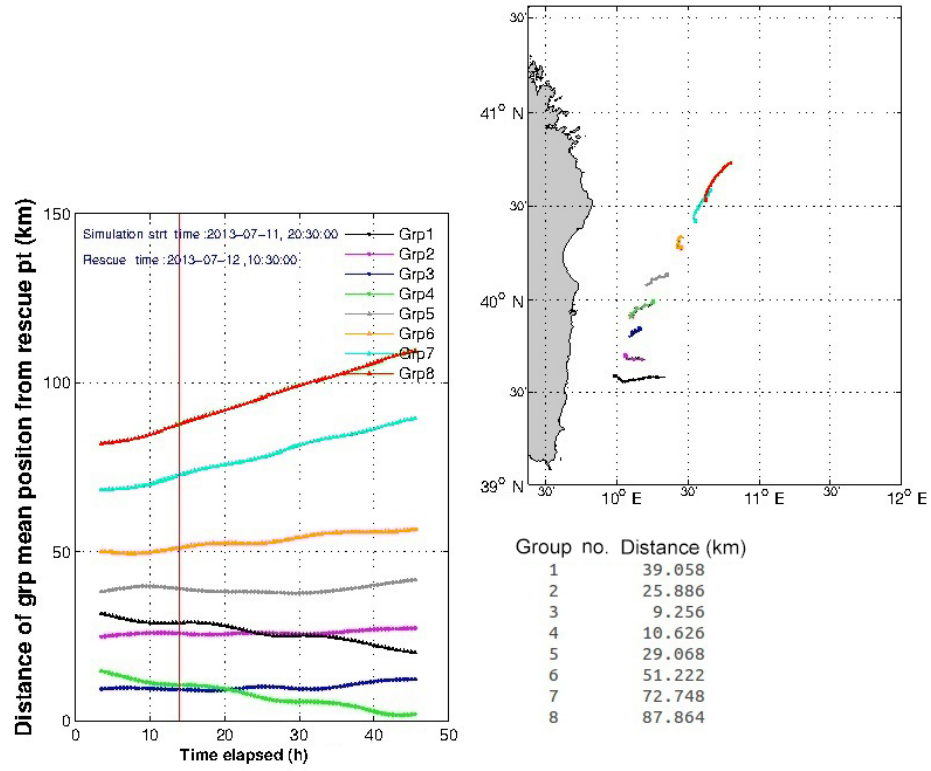
Figure 4. Distance of the mass center of each group planted every 30min from 20:30UTC (group 1) on 11 July 2013 to midnight the following day (group 8), corresponding to the solution in Fig. 3. It may be possible to verify that the lower distances at the rescue time (values at right and low part of the panel) are reached by the mass center of the third subset of particles (planted from 21:30 to 22:00UTC). The smallest distance is reached 31.5h later by the fourth subset (planted from 22:00 to 22:30UTC) and is about 2km. On the upper right side of the image, the trajectories of each group’s mass center throughout the simulation (43h) are